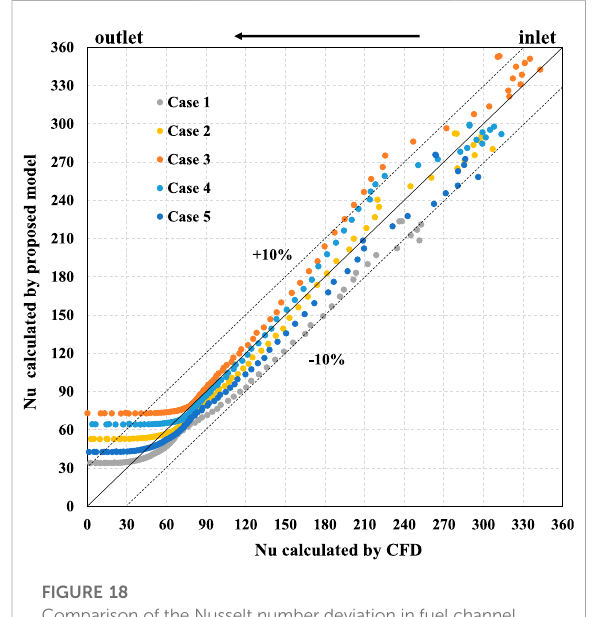
FIGURE 18 Comparison of the Nusselt number deviation in fuel channel by two methods.